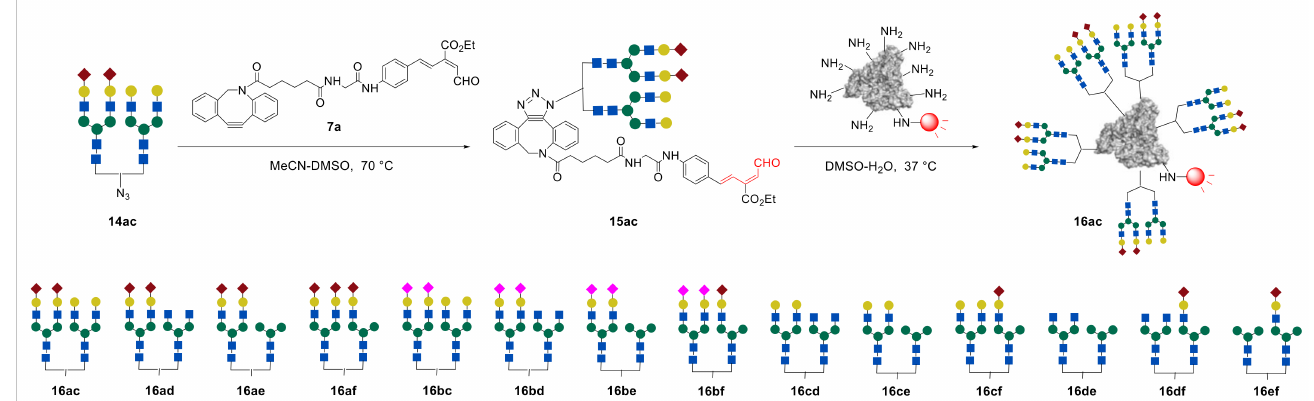
Figure 11. Synthesis of heterogeneous structurally well-defined glycoalbumins 16 containing two dif- ferent N -glycan fragments by simultaneous immobilization of heterogeneous glycan–aldehydes 15 : representative synthesis of heterogeneous glycoalbumin 16ac ; synthesized glycoalbumins 16ac – ef [44]. Copyright Wiley-VCH GmbH. Reproduced with permission.